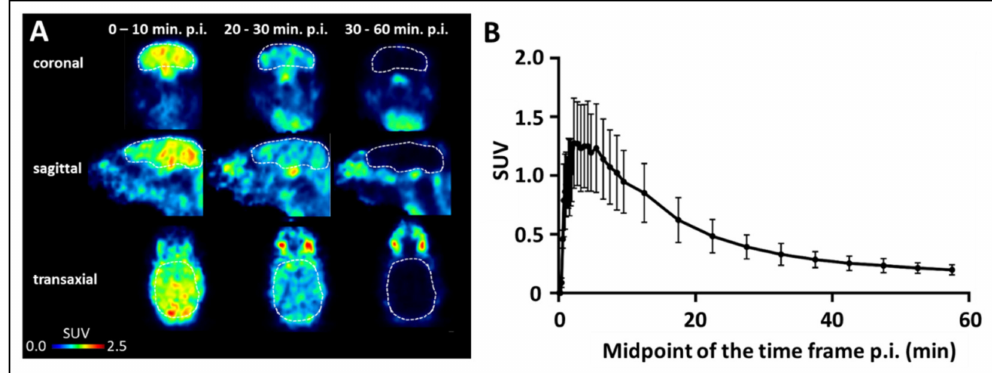
Figure 6. [ 18 F] RM273 is able to penetrate the BBB in healthy mice. ( A ) Representative time-averaged coronal, sagittal, and transaxial PET images of [ 18 F] RM273 . The brain is outlined in white. ( B ) Time–activity curve (mean ± S.D.) of the whole brain region delineated in ( A ) of [ 18 F] RM273 in mice ( n =